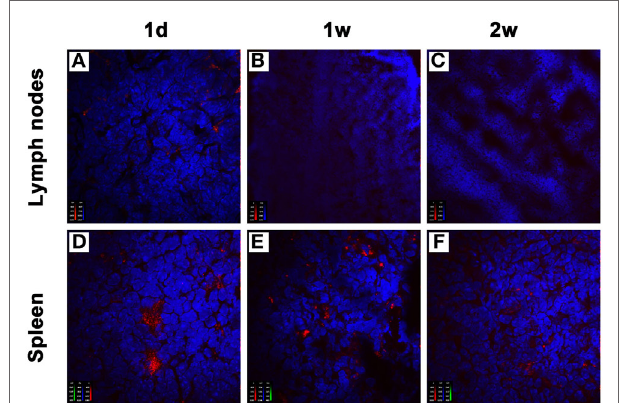
FigUre 5 | Donor-derived immature dendritic cells (imDCs) are mainly located in recipient spleens after adoptive transfer. Untreated BALB/c mouse-derived imDCs (5 × 10 6 ) labeled with CellVue Claret (red) were intravenously injected into C57BL/6 recipients. At 1, 7, and 14 days after the injection, mesenteric lymph nodes (a–c) and spleens (D–F) were harvested to detect the localization of allogeneic imDCs. After staining with DAPI (blue), tissue sections were observed under a confocal imaging system. The photographs shown are representative of three independent experiments.